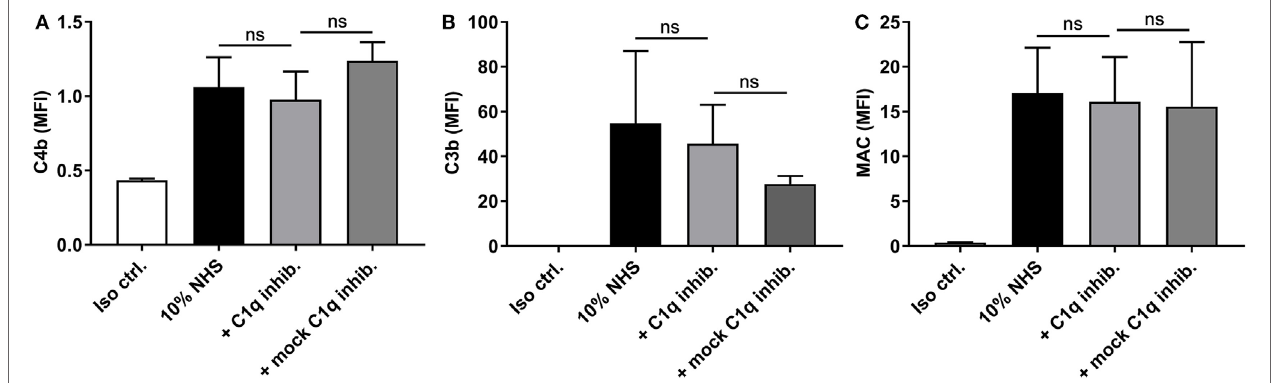
FigUre 7 | Inhibitory effects of a C1q inhibitor on C4b, C3b, and membrane attack complex (MAC) deposition. 10% normal human serum (NHS) was combined with C1q inhibitor C1q-85 (5 µg/ml) and incubated with isolate C322-17. Detection was done with specific biotinylated monoclonal antibodies against (a) C4b, (B) C3b, and (c) MAC, followed by FITC-conjugated Streptavidin. Complement deposition was measured by flow cytometry and expressed as mean fluorescence intensity (MFI). Results represent the means of three independent experiments ± SD. No significant differences were detected between the C1q inhibitor and the mock inhibitor, ns p > 0.05 (unpaired Student’s t